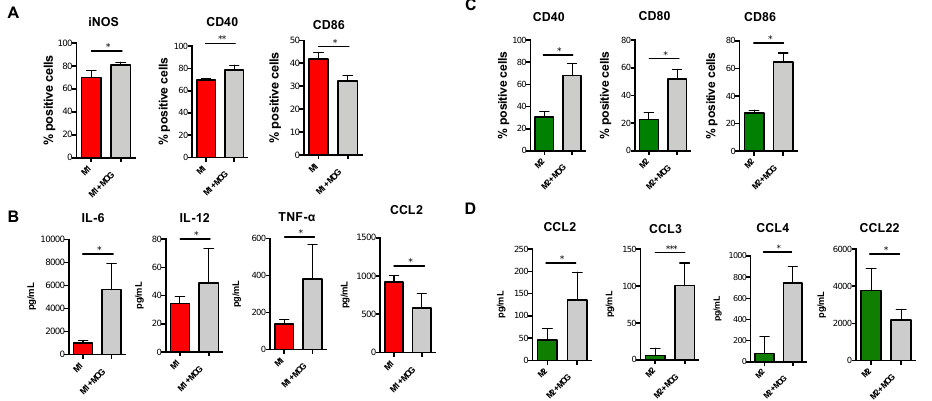
Figure 7. Immunophenotype of MOG-immunized M1 and M2 macrophages obtained from CFA mice. Monocytes obtained from spleen of CFA mice were differentiated into macrophages using M- CSF (50 ng/mL) for 6 days and then polarized into M1 with IFN- γ (10 ng/mL) plus LPS (1 μg/mL) or into M2 with IL-4 (20 ng/mL) for 2 more days in the presence of myelin oligodendrocyte glycoprotein epitope (MOG35-55). ( A ) Expression of markers by flow cytometry upon staining cells at cell surface (CD40 and CD86) or intracellularly (iNOS). Data are reported as percentage of positive cells and are representative of four independent experiments ± SEM. * p < 0.05, ** p < 0.01 ( B ) ELISA of cytokines and chemokines (IL-6, IL-12, TNF- α and CCL2) in supernatants of MOG-immunized M1 macrophages obtained from CFA mice. Data are reported as pg/mL and represent eight independent experiments means ± SEM. * p < 0.05 ( C ) Expression of markers by flow cytometry upon staining cells at cell surface (CD40, CD80 and CD86). Data are reported as percentage of positive cells and are representative of eight independent experiments ± sem. * p < 0.05, ( D ) ELISA of chemokines (CCL2, CCL3, CCL4, and CCL22) in supernatants of M2 macrophages. Data are reported as pg/mL and represent eight independent experiments means ± SEM. * p < 0.05, *** p < 0.001.